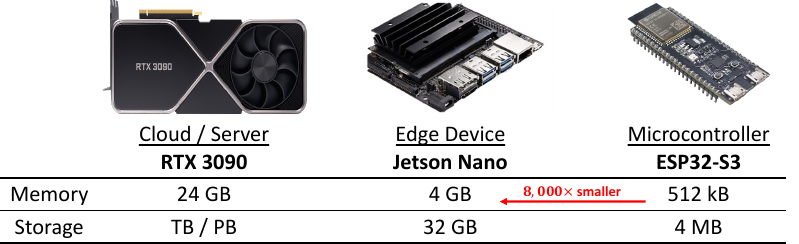
Figure 1. An illustration of the resource constraints of MCUs. MCUs are approximately 8000 × and 48,000 × more constrained in terms of memory and storage compared to Nvidia Jetson Nano and RTX 3090,